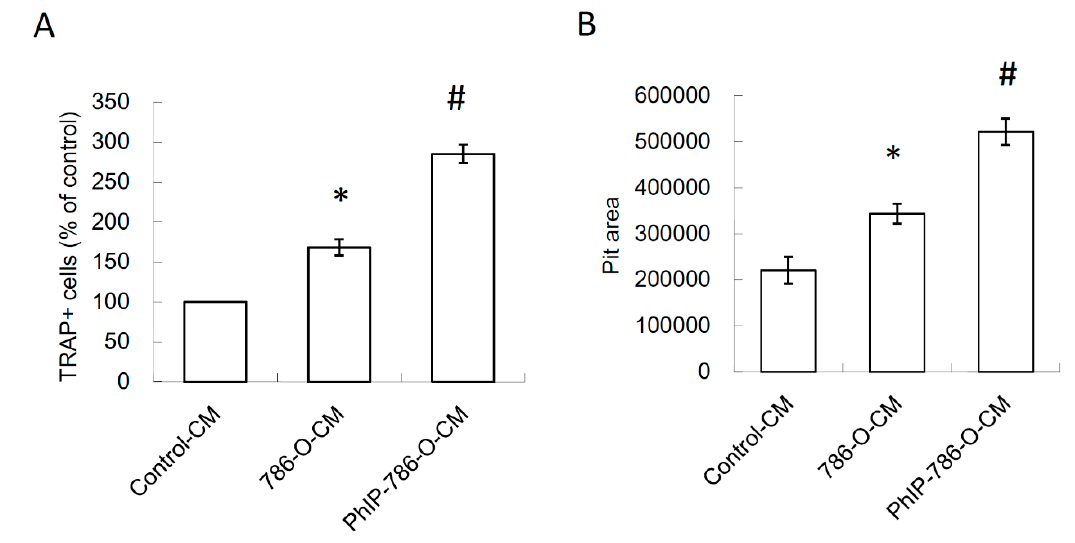
Figure 3. PhIP reinforced the stimulatory effect of human 786-O renal cell carcinoma on osteoclastogenesis and bone resorption on CD14 + monocyte-differentiated osteoclasts. ( A ) The TRAP-positive cells in CD14 + monocyte-differentiated cells after different CM treatment. ( B ) Bone resorption activity. Each value is shown as the mean ± SD of three independent experiments. * Significant difference with control-CM treatment, # Significant difference with 786-O-CM treatment, P < 0.05. 3.4. PTHrP / IL-8 Autocrine Loop was Involved in the Stimulation of PhIP on Renal Cell